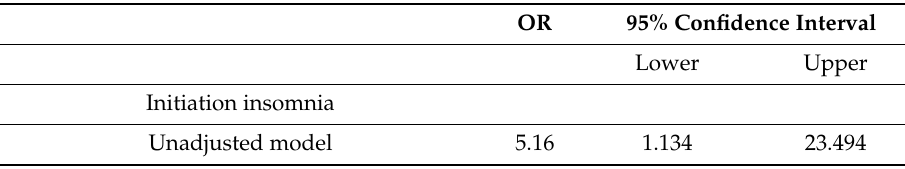
Table 3. Gender e ff ect on insomnia and the onset of sleep complaints.